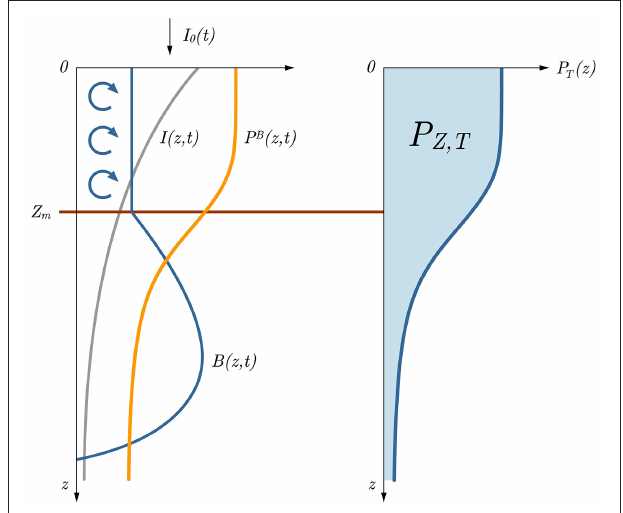
FIGURE 1 | Sketch of the basic model relations with respect to depth. With the information on surface irradiance I 0 ( t ) and the optical properties of the water column, the irradiance at depth I ( z , t ) (gray curve) is first calculated. Using I ( z , t ) and the photosynthesis irradiance function p B ( I ), along with the information on biomass B ( z , t ) (blue curve on the left hand side), normalized instantaneous production P B ( z , t ) is obtained (orange curve). Further on, taking the product of B ( z , t ) and P B ( z , t ) and integrating it over time we get the daily production at depth (blue curve on the right hand side). In this depiction watercolumn production P Z , T is the blue surface under the P T ( z ) curve. Blue arrows indicate mixing and Z m marks the mixed layer depth. Daily production from the surface up to Z m is marked with P Z m , T